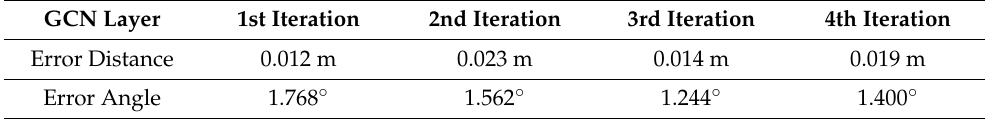
Table 5. Error angle and error distance by the number of iterations in the 7-Scenes Dataset.